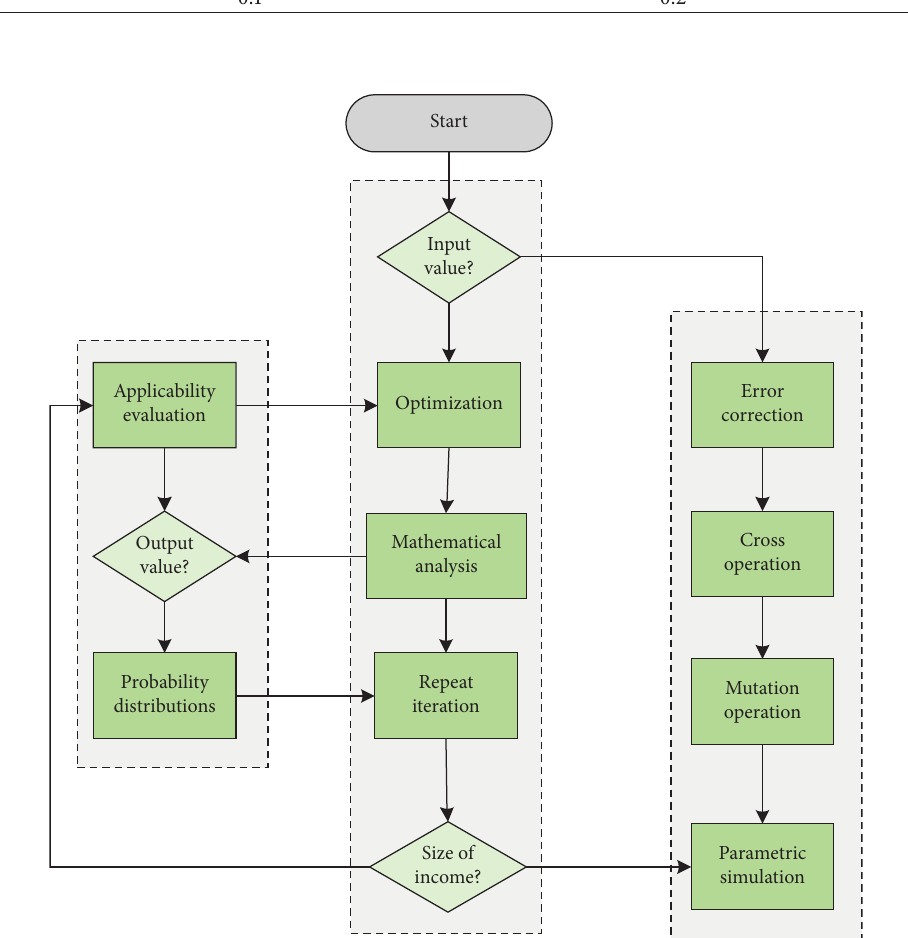
Figure 1: Hybrid strategy evolutionary